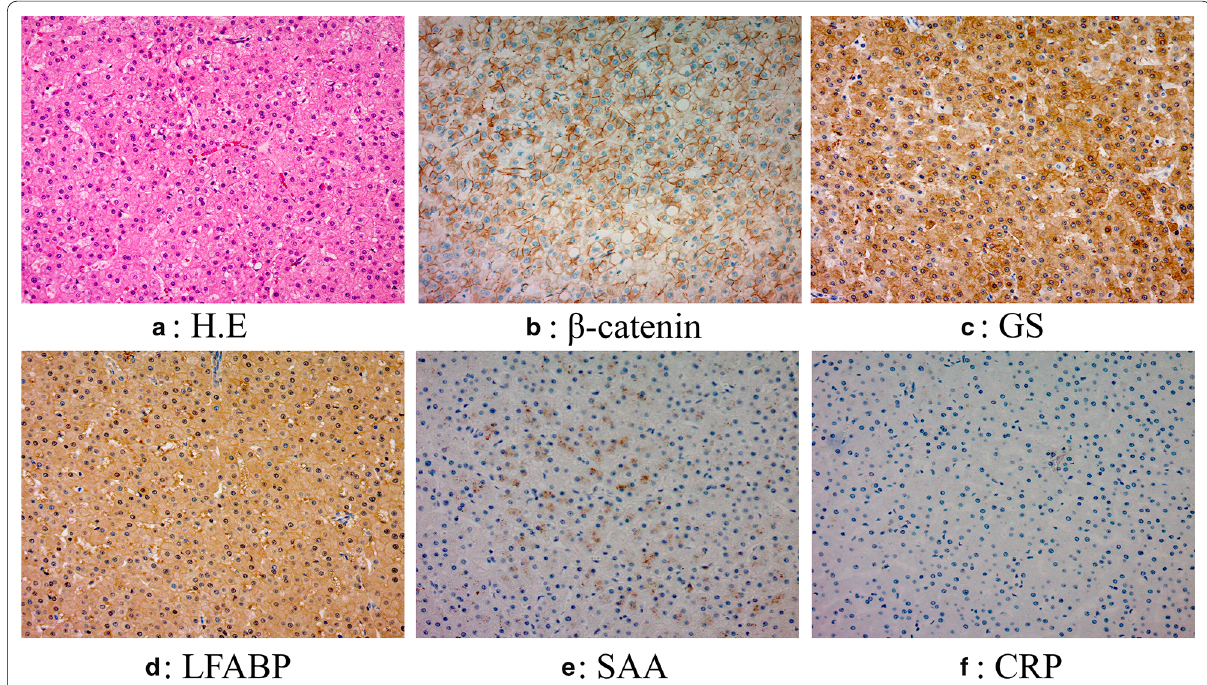
Fig. 4 Histopathology and immunohistochemistry findings. Hepatocellular cells with poor atypia proliferated diffusely in the tumor ( a ) H&E staining (magnification, 200 ). Immunohistochemical analysis shows positive β-catenin in the cellular membrane and negative in the nucleus × (magnification, 200 ) ( b ), diffuse GS (magnification, 200 ) ( c ), LFABP is positive (magnification, 200 × × ( e ), and CRP is negative (magnification, 200 ) ( f ). H&E stain, hematoxylin and eosin staining; GS, glutamine synthase; LFABP, liver fatty acid-binding × protein; SAA, serum amyloid A; CRP, C-reactive protein